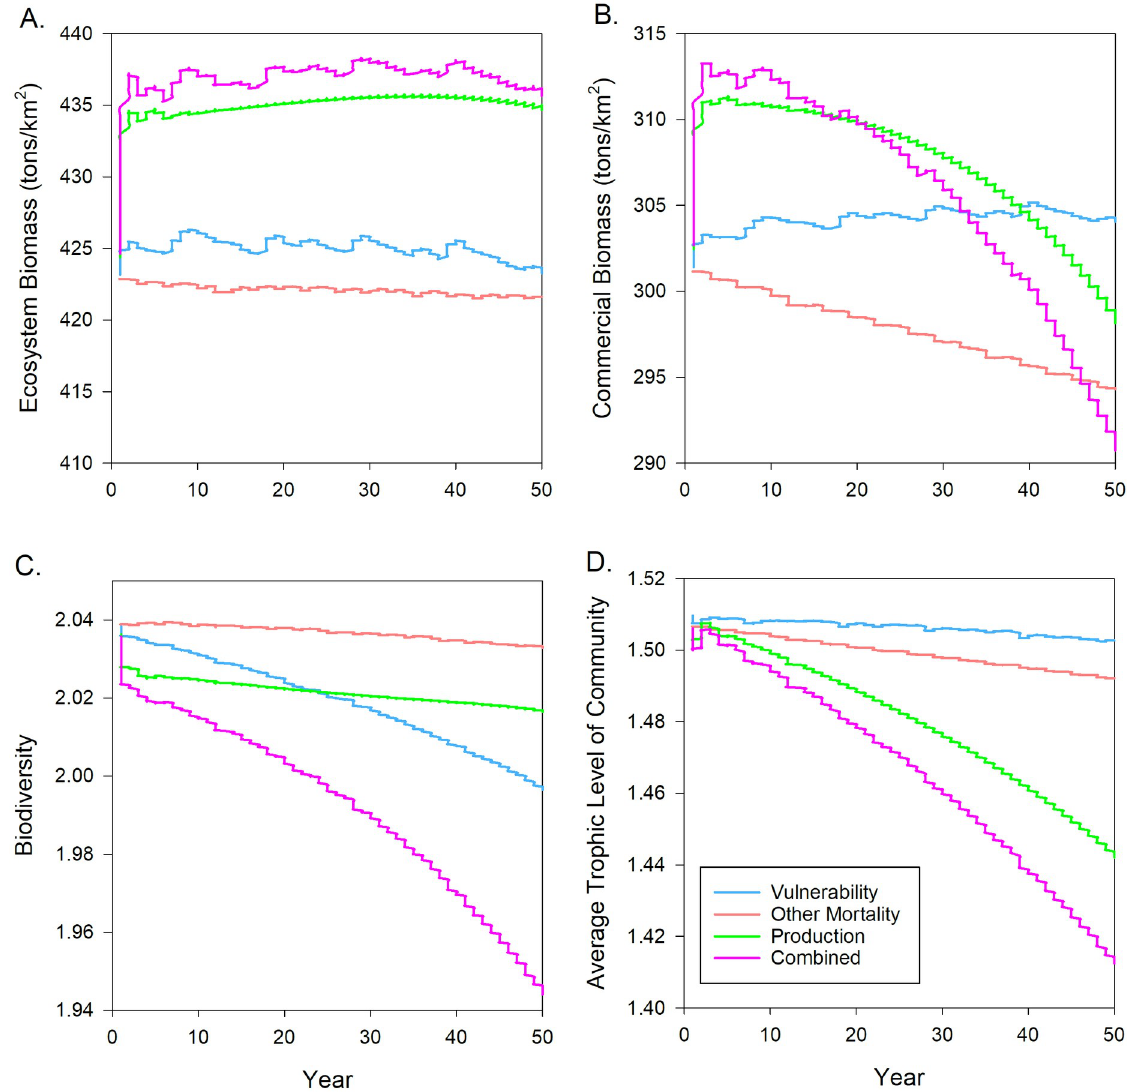
Fig 4. Plot of changes in total biomass, commercial biomass, biodiversity, and average trophic level of the community ecological indicators across production, other mortality, vulnerability, and combined forcing simulations over 50 years, with pH dropping from 8.0 to